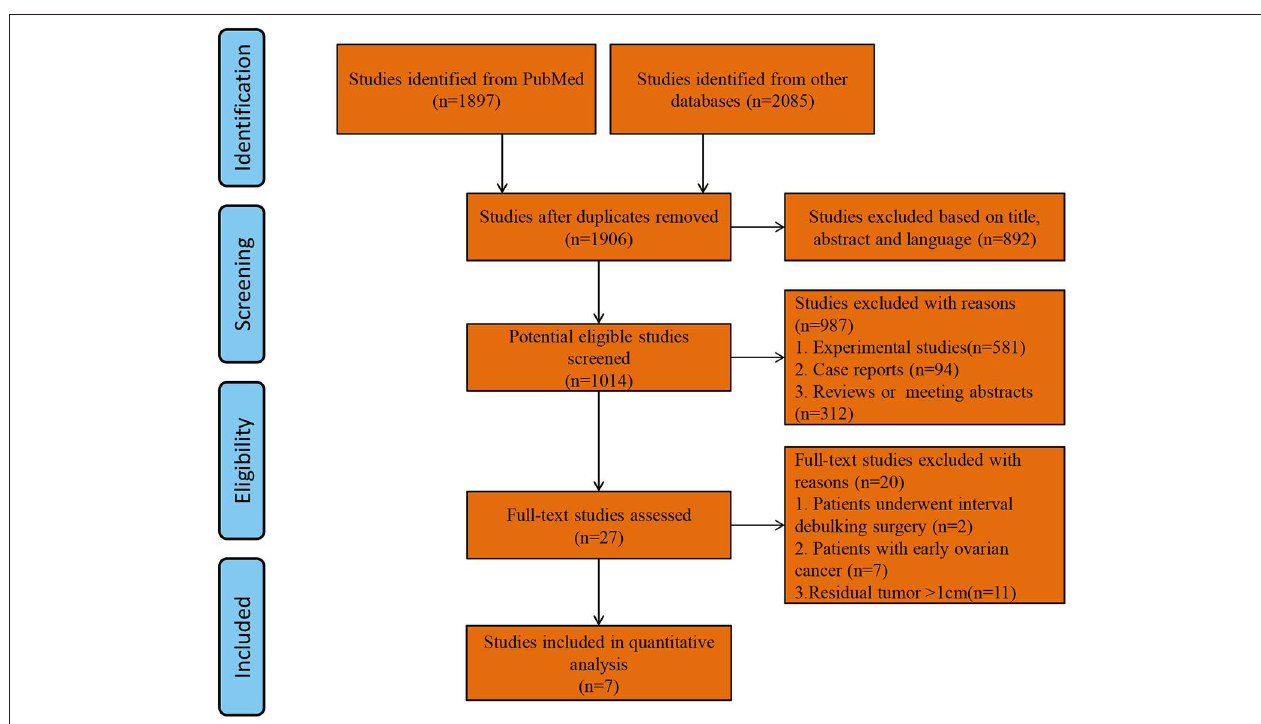
FIGURE 1 | Flow diagram of study selection.